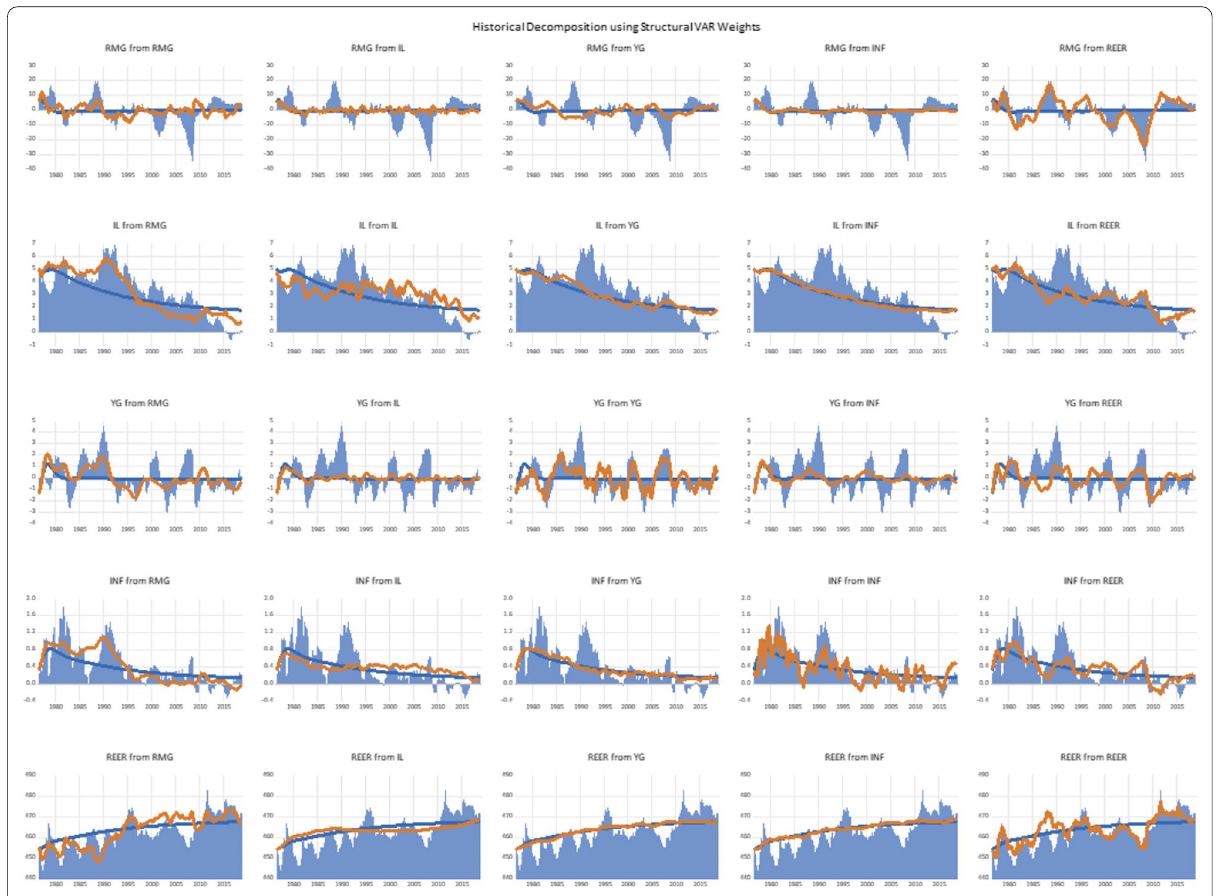
Fig. 9 Historical decomposition, SVAR